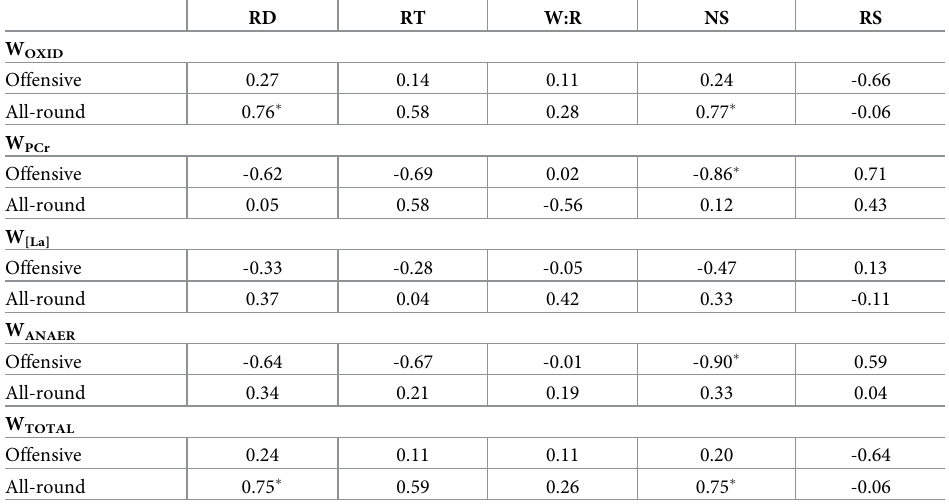
Table 2. Pearson’s correlation (r) between energy systems contribution and temporal variables analyzed by play- ing style. RD RT W:R NS